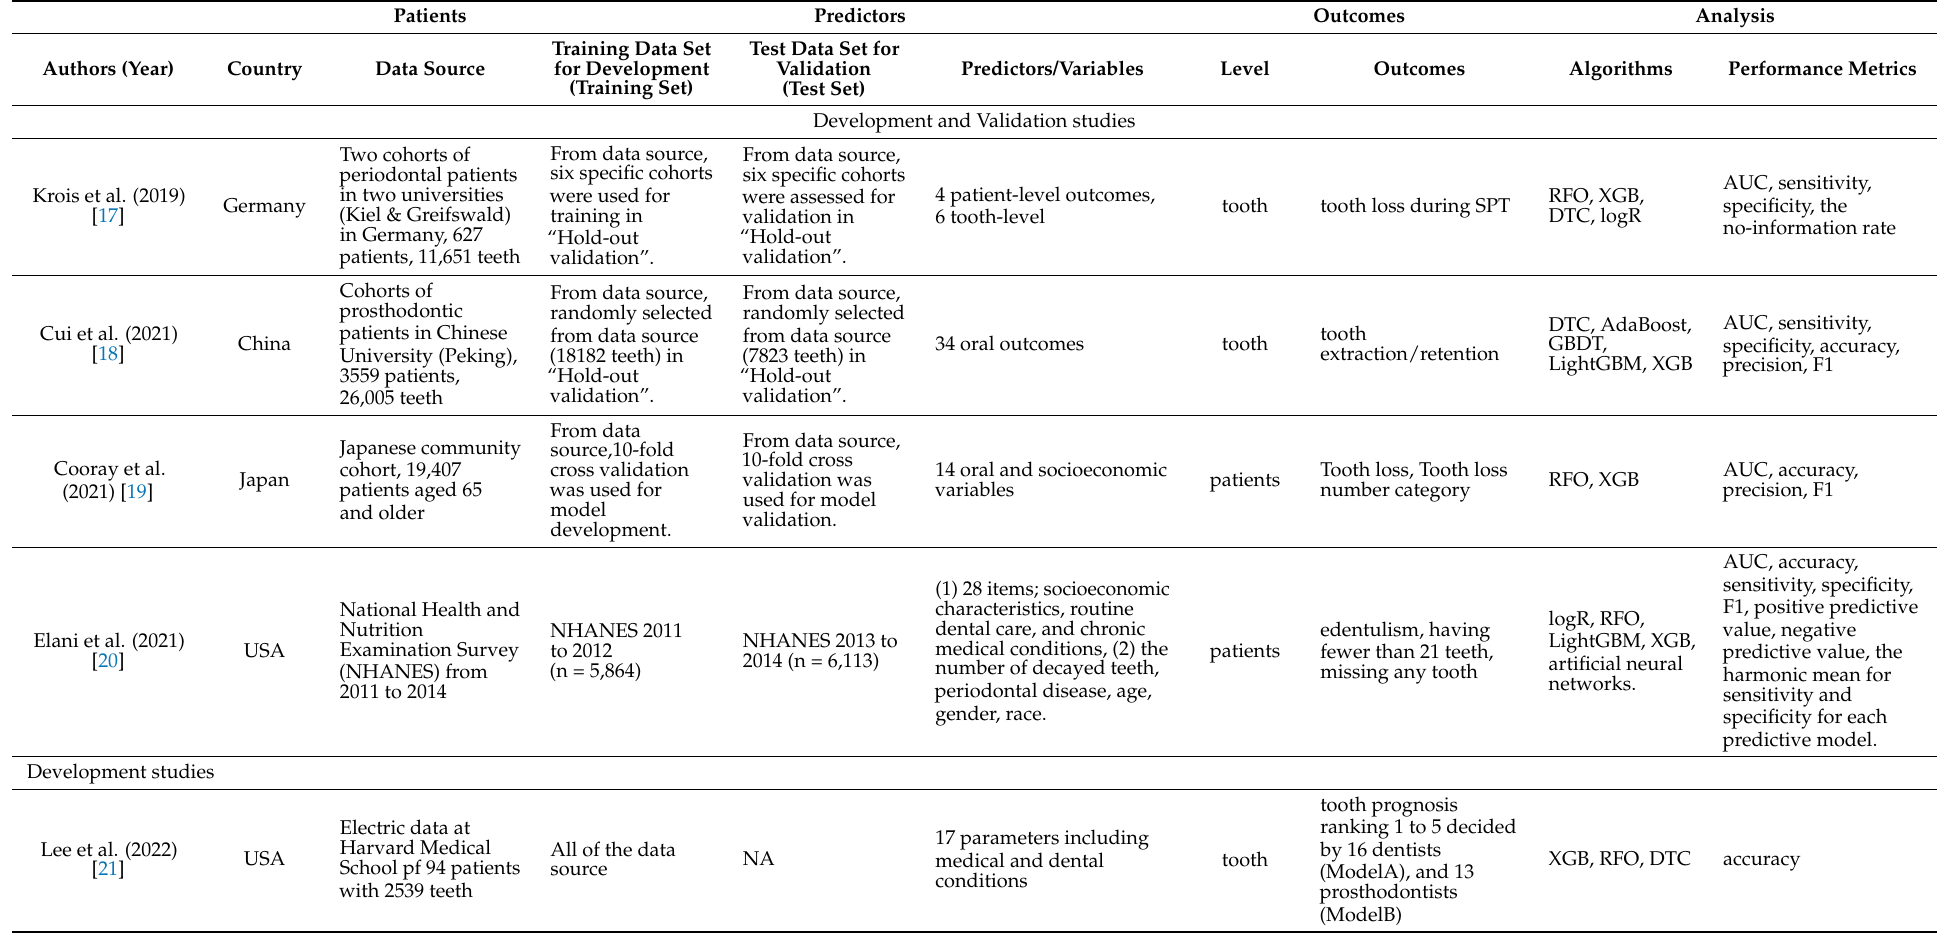
Table 1. Characteristics of included